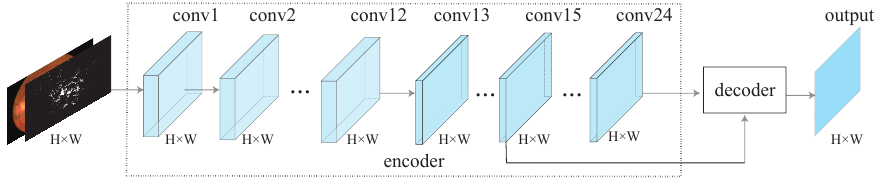
Figure 2. An overview of the proposed LightEyes. For simplicity, nonlinear activation functions (ReLU) are omitted. The encoder maintains a high resolution representation directly to facilitate the segmentation of tiny lesions and vessels. To be specific, the encoder contains 24 convolutional layers, and the decoder uses features of the intermediate layer to generate